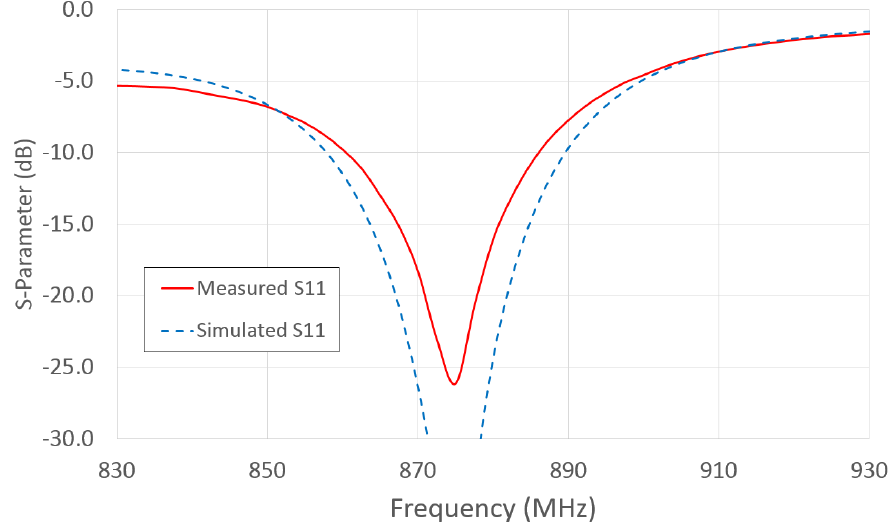
Figure 9. Simulated and measured reflection coefficient of the complete system.